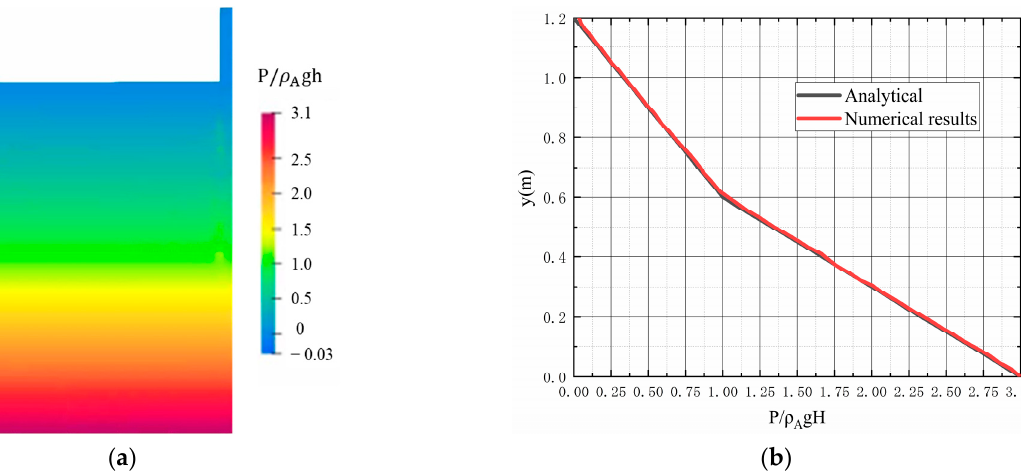
Figure 8. ( a ) Snapshot of the pressure field at t = 3.5 s; ( b ) pressure profile at t = 3.5 s.